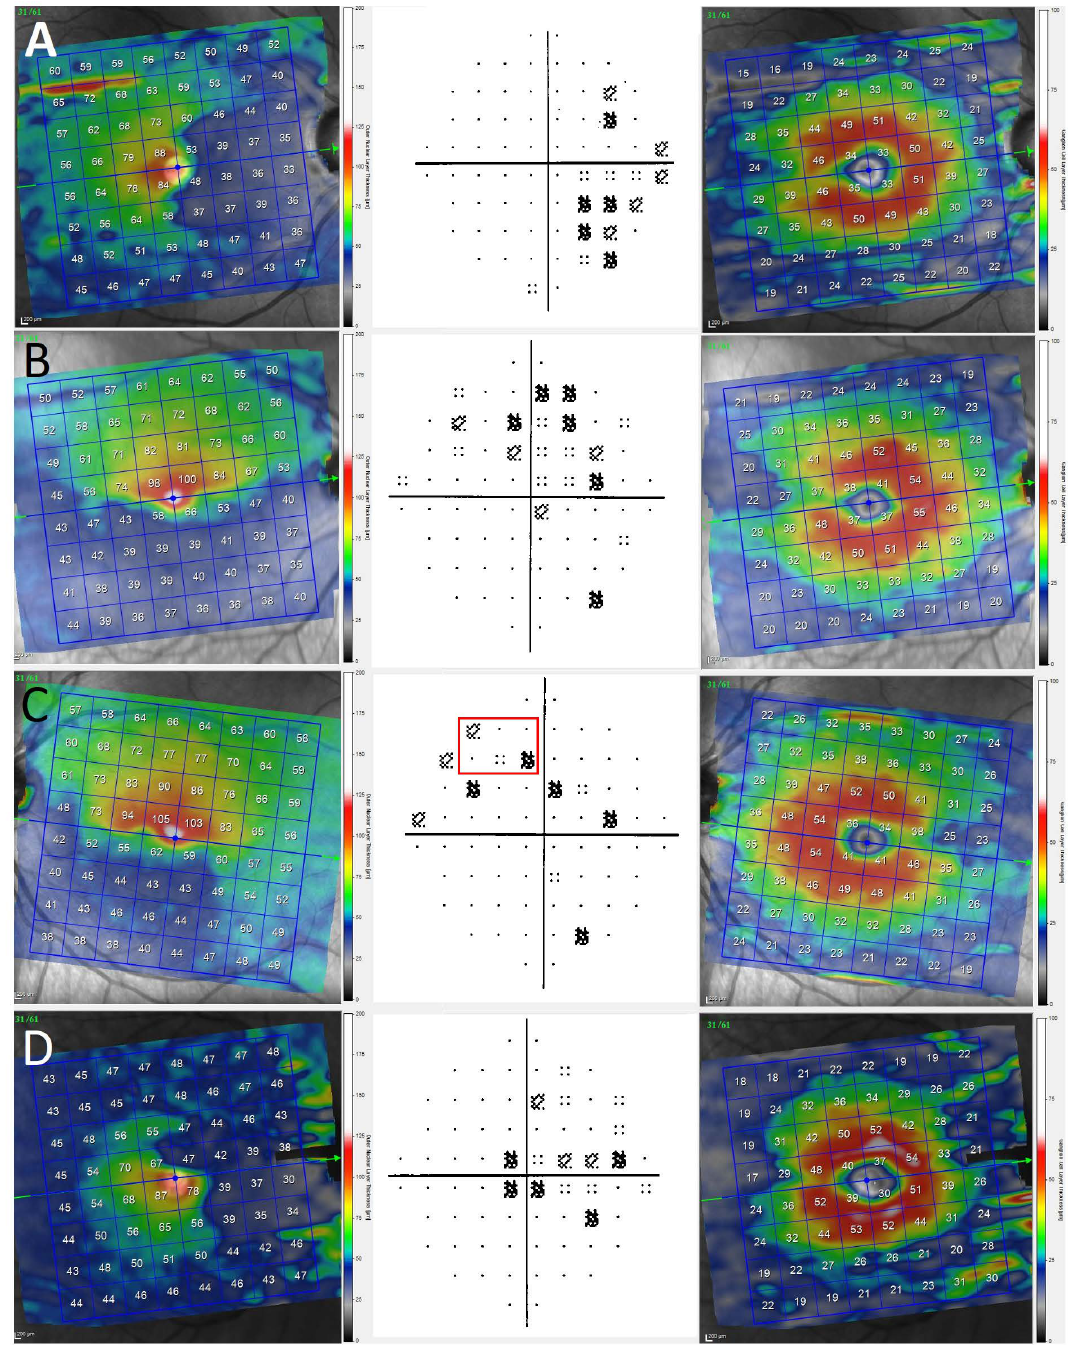
Figure 2. Three di ff erent patients ( A – D ) with HCQ retinopathy with their visual fields and OCT, showing a perfect correspondence of both damage tests. Left images show the outer nuclear layer (ONL) analysis, center images the visual fields (VFs), and right images represent ganglion cell layer (GCL) analysis. ( A ) right eye of a 65-year-old woman with systemic lupus erythematosus that presented with nasal damage of ONL-associated temporal damage of VF with normal GCL analysis; ( B , C ) right and left eyes of a 71-year-old woman with RA showing inferior impairment of ONL and superior VF damage, keeping a nonaltered GCL measurement; ( D ) 53-year-old man with systemic lupus erythematosus and nasal damage of ONL with temporal damage of VF preserving normal GCL analysis. Green arrows represent the horizontal line centred in fovea. The symbols in the red box represents de located damage in visual